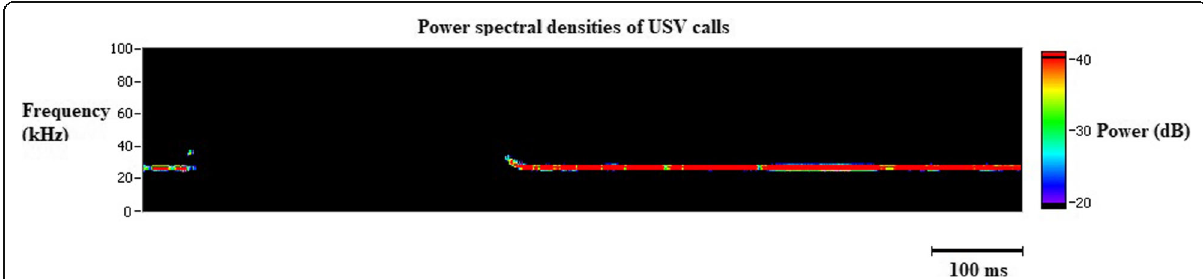
Fig. 2 Demonstration of ultrasonic vocalisation (USV) calls in an awake rat following a cortical spreading depression. Emission of USV calls in the 22 – 27 kHz range in adult rats indicate a negative affective state such as pain or distress. The shift in the frequency at the beginning and at the end of the ultrasonic vocalisation is the typical feature of a biological